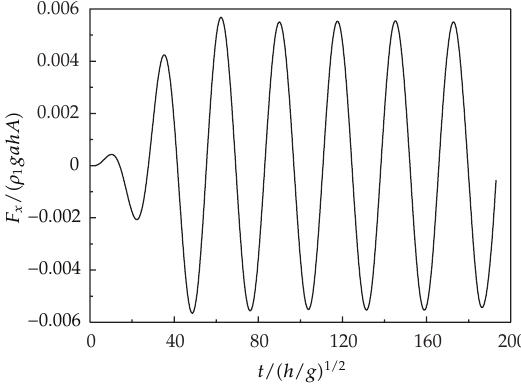
Figure 3: Time histories of horizontal wave